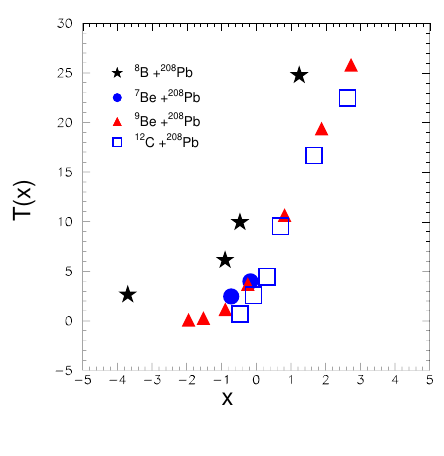
Figure 7. Reduced total reaction cross sections as a function of a reduced energy. The reduction is according to Wong relations as reported before in Ref. [23]. The cross sections are experimental or / and theoretical values from Refs. [4, 14] for 8 B, [24] for 7 Be, [25] for 9 Be and [26], for 12